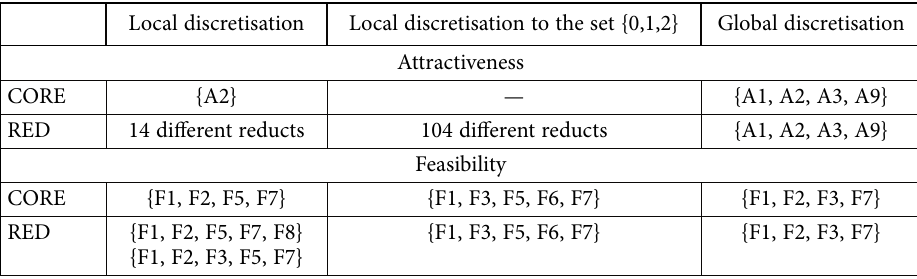
Local discretisation Local discretisation to the set {0,1,2} Global discretisation